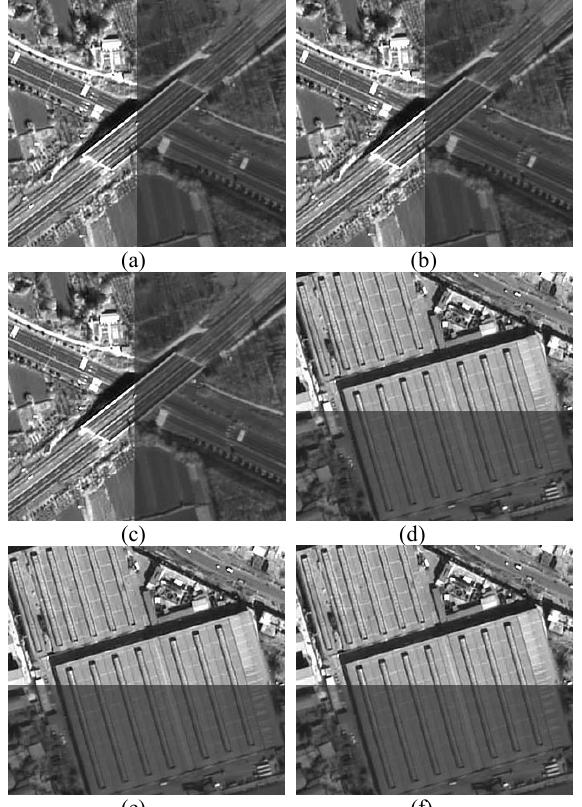
Figure 4. Stitching effect of test areas. (a) across track stitching effect with 30m DEM, (b) across track stitching effect with 90m DEM, (c) across track stitching effect with 1km DEM, (d) along track stitching effect with 30m DEM, (e) along track stitching effect with 90m DEM, (f) along track stitching effect with 1km